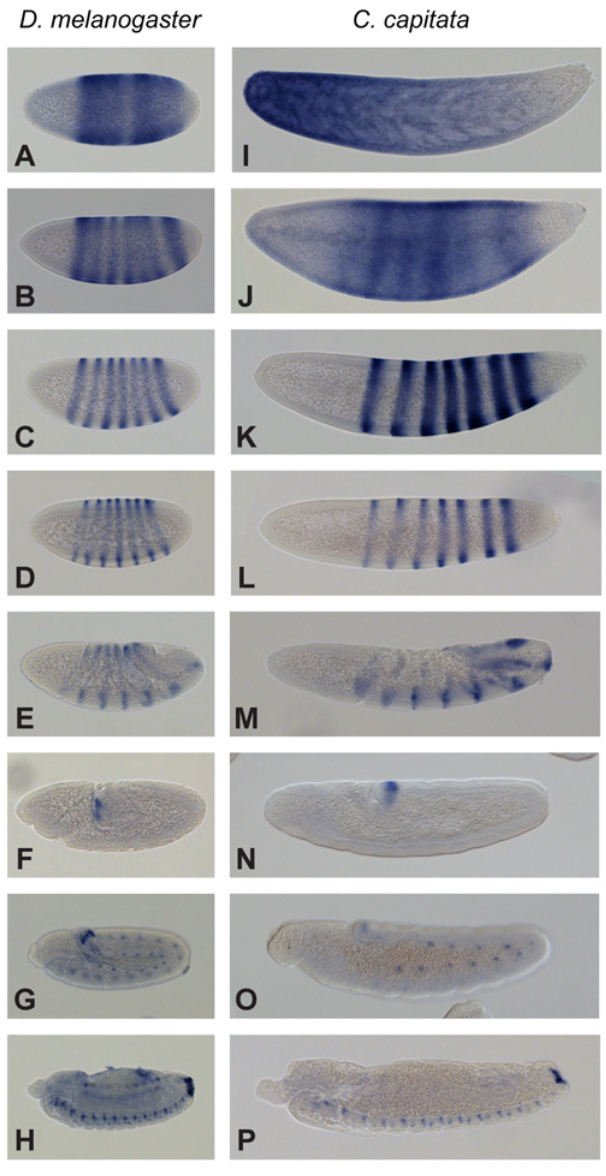
Figure 6. Native expression pattern of eve in Drosophila melanogaster and Ceratitiscapitata . even-skipped expression patterns in D. melanogaster (A–H) and C. capitata (I–P) embryos were visualized by in situ hybridization with species-specific digoxigenin-labeled antisense RNA probes. While clear differences are manifest in the extremely early phases of expression ( D. melanogaster stage 4–5, fixed 2–4 h AEL panels A,B; C. capitata fixed 0–8 h AEL panels I, J), Previously characterized epochs of eve expression appear substantially conserved. Parasegmental expression is conserved in the blastoderm and gastrulating embryo ( D. melanogaster fixed 0–4 h AEL panels C, D and E, respectively, C. capitata fixed 8–32 h AEL panels K, L and M, respectively). So too is the post-gastrula expression domain of eve in the posterior, and in mesodermal lineages of the germ band extended embryo ( D. melanogaster fixed 0–18 h AEL panels F, G, C. capitata fixed 8–32 h AEL panels N, O) and the neuronal and anal plate ring expression domains in the late embryo ( D. melanogaster fixed 0–18 h AEL panel H, C. capitata fixed 26–50 h AEL panel P).